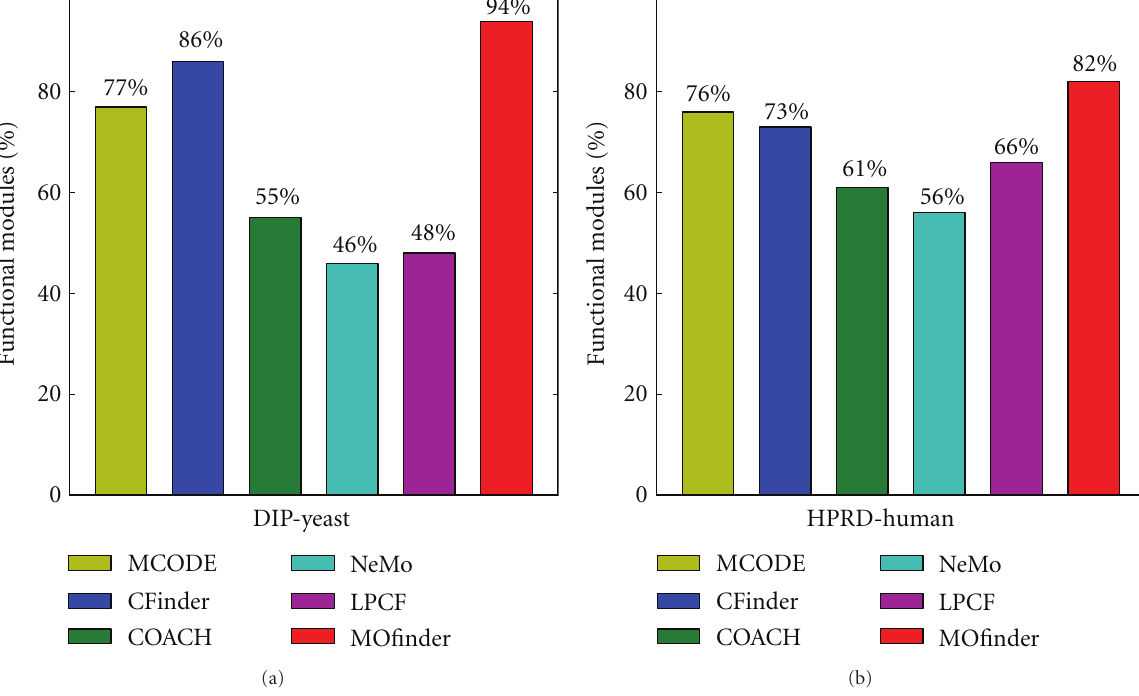
Figure 4: Comparative performances of MOfinder and the other five methods. The y -axis represents the proportion of functional modules of detected modules, according to GO annotation (Bonferroni P -value <